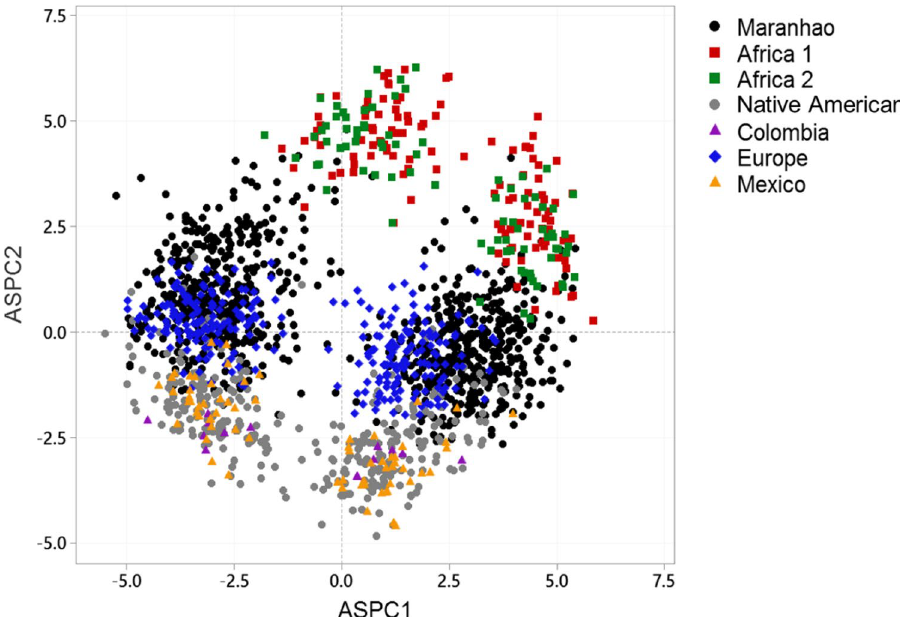
Figure 2. Ancestry specific by principal components analysis of admixed individuals and geographical reference groups. Africa 1 (Angola, Botswana, Namibia, South Africa, Lesotho, Central African Republic, Congo, Kenya), Africa 2 (Senegal Nigeria) Europe (France, Italy, Russia, Orkney Islands), Mexico (Maya and Pima), Brazilian Native American (Karitiana, Surui, Santa Isabel and Terena).